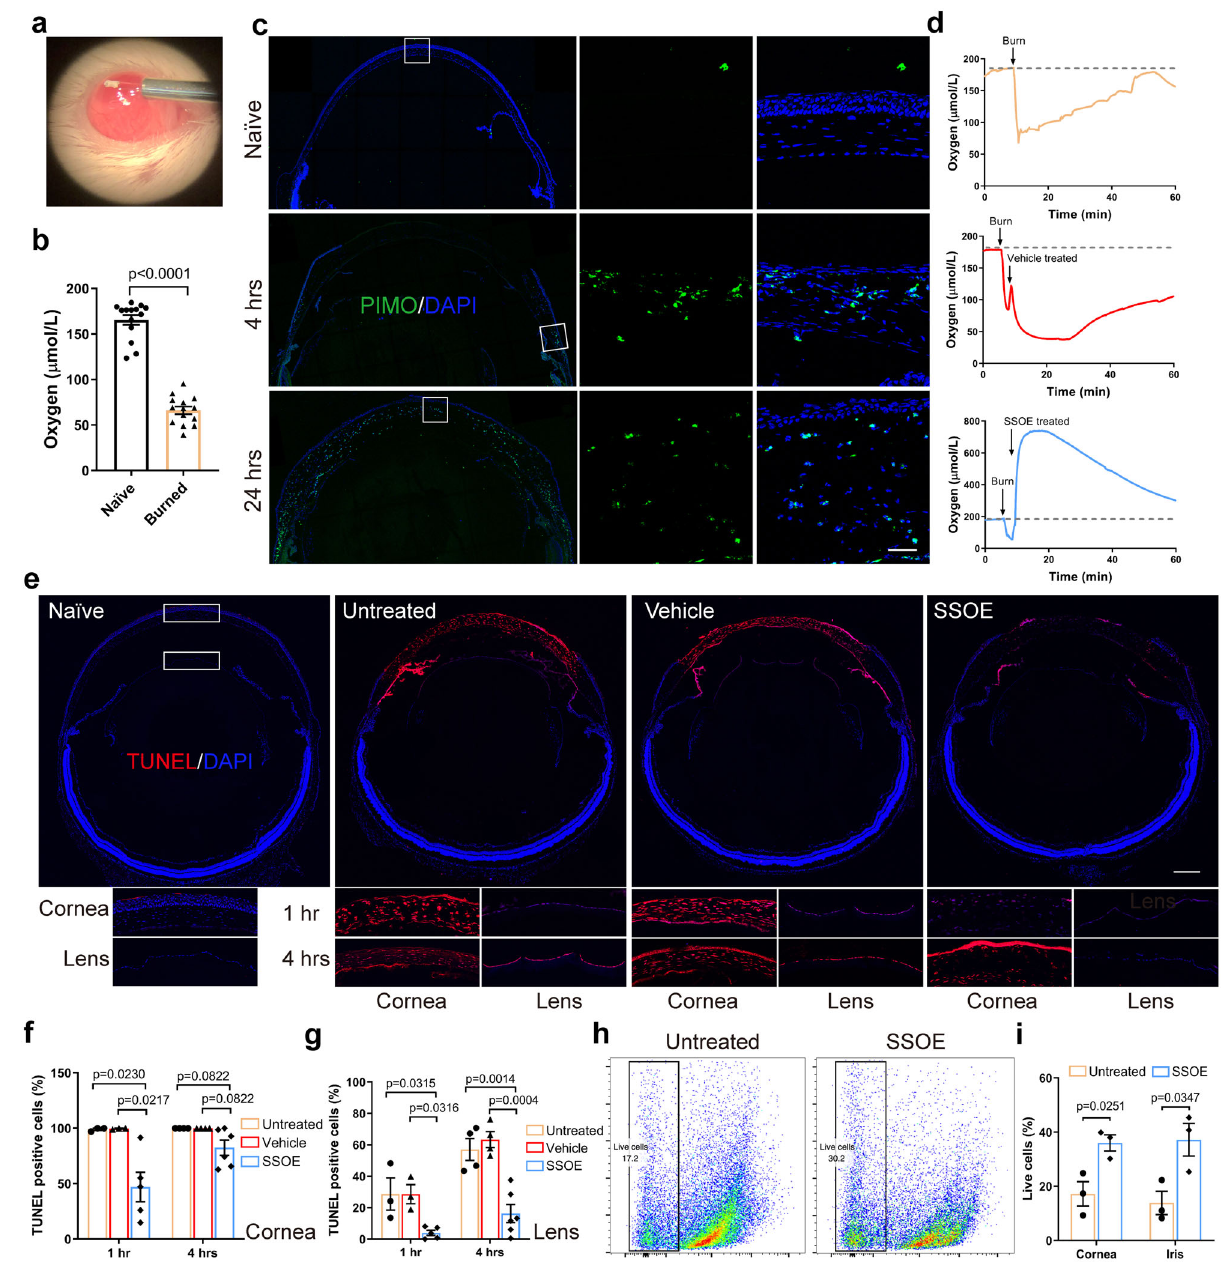
Fig. 6 | SSOE reduces ocular tissue hypoxia and cell death after alkali burn. a Oxygen concentration in anterior chamber (AC) was recorded in real time by insertingamicro-oxygensensor. b ACoxygenleveldecreasedby60%immediately after alkali burn. Data are presented as mean±SEM. Statistical signi fi cance was determined using unpaired, two-tailed Student ’ s t test. n =14 eyes in each group. c Pimonidazolehydrochloride(PIMO)staining,achemicalhypoxiamarker,showed limbal staining at 4h post burn and diffuse staining in the entire cornea by 24h (inserts showed higher magni fi cation of selected areas in white boxes, scale bar 10 μ m). Data are representative of three independent experiments. d In untreated and vehicle-treated eyes, AC oxygen concentration decreased rapidly after burn and gradually increased within one hour. SSOE raised AC oxygen concentration to supra-physiologiclevelafterburnandmaintainedhighlevelsformorethan60min. Dashed line represents baseline AC oxygen concentration. e Whole mouse globe wascryo-sectionedandTUNEL(red)staininghighlighteddeadcellsintheeyeat1h